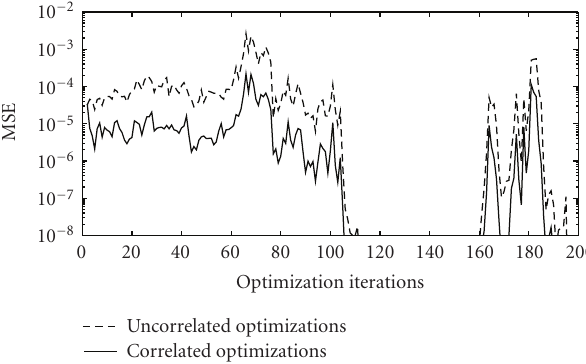
Figure 12: Example of time-variation of the SNR received by each sensor. Figure 13: Precision reached with correlated and uncorrelated genetic optimizations of LSC, in terms of Mean Square Error (MSE) with fixed number of generations.